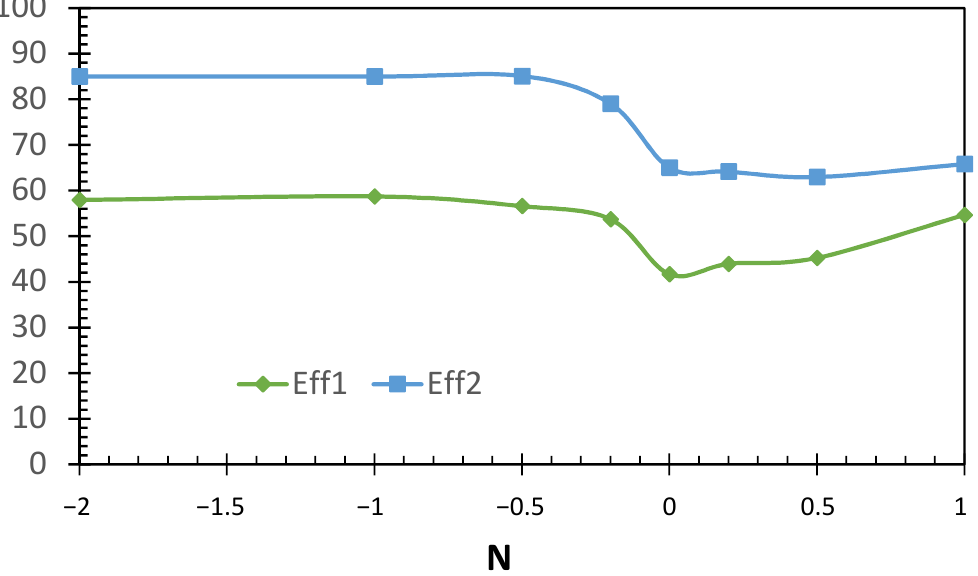
Figure 16. Effect of the buoyancy ratio on the efficiency of the barrier for Ra = 2 × 10 4 ; Eff1 and Eff2 are the efficiencies for H 1 = 0.25 and H 2 = 0.5, respectively.